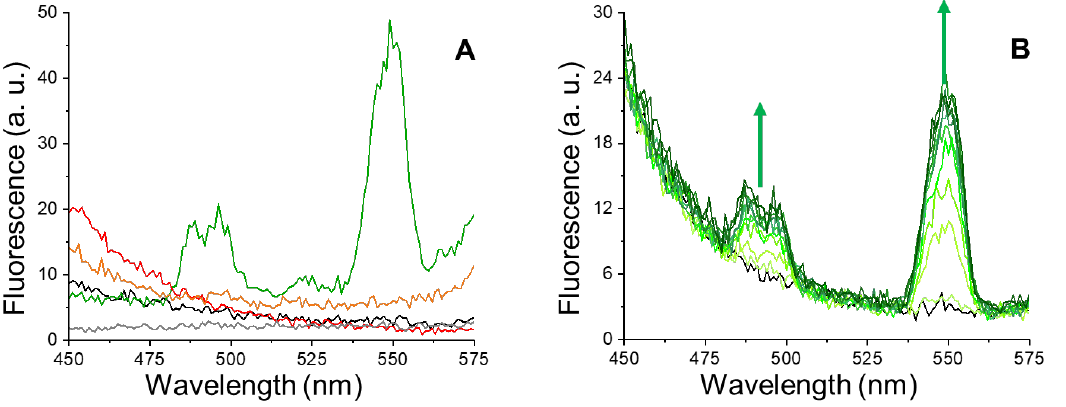
Figure 1. Lf-Tb 3+ fluorescence spectroscopy. ( A ) Fluorescence emission spectra of commercial Apo-Lf (black line) and Fe 3+ -Lf (red line) in the absence of TbCl 3 . Emission spectra of Apo-Lf (green line) and Fe 3+ -Lf (orange line) in the presence of 150 µ M TbCl 3 . The spectrum of a 150 µ M TbCl 3 solution in the absence of proteins is also reported (gray line). ( B ) Representative fluorescence emission spectra of pooled tear samples in the presence of TbCl 3 (0–150 µ M). Green arrows indicate the direction of spectral changes at increasing concentrations of